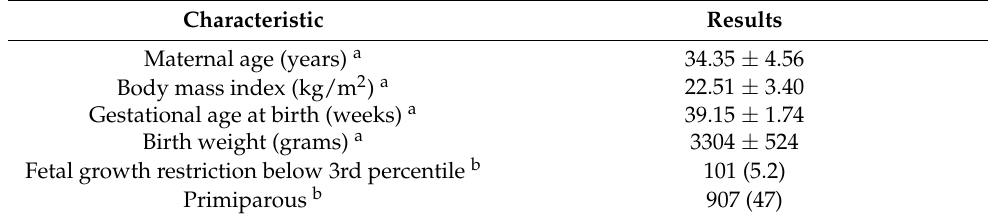
Table 1. Patient’s characteristics (n = 1930). Characteristic